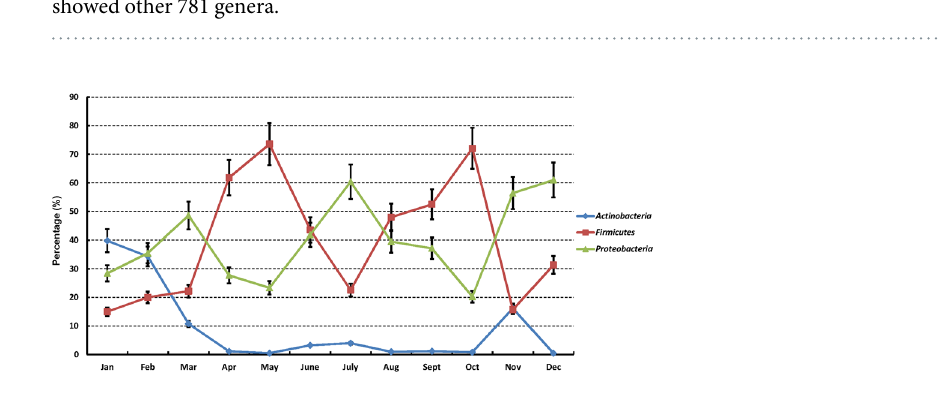
Figure 3. Microbiota variation of three phyla in 12 months. These three phyla showed the difference by the months which might be caused by the temperature and humidity changes. The three phyla were Actinobacteria (0.4%~39.8%), Firmicutes (15.0%~73.6%) and Proteobacteria